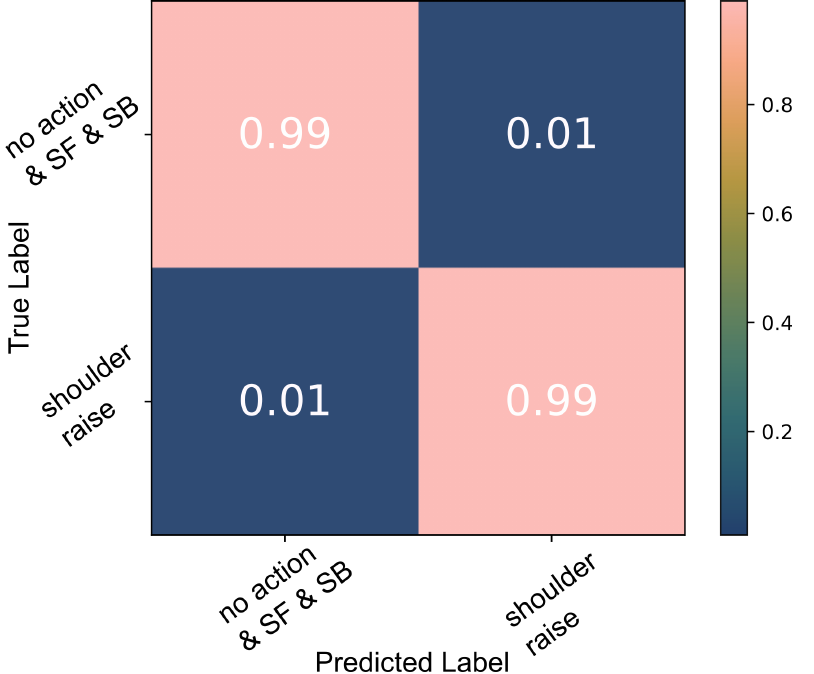
Figure 3. The decision tree classification results of the able-bodied participants’ SR data; the model was tested against SR , SF and SB